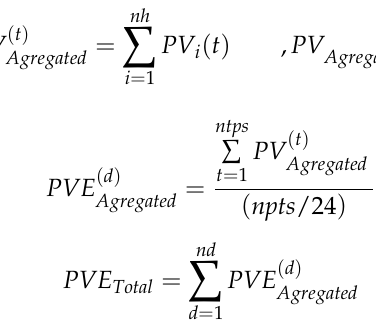
Figure 4. PV generation profiles for five different solar variability types.